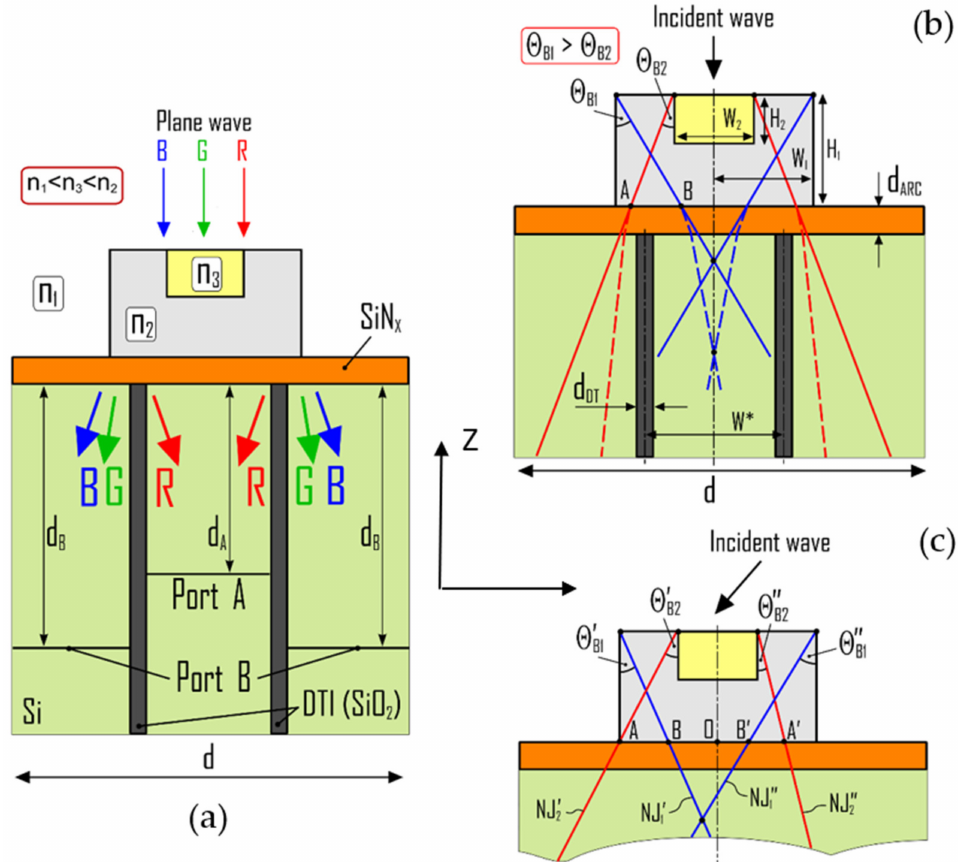
Figure 1. ( a ) Topology of a NJ-based dielectric color splitter for normal incidence; ( b ) Cross-section view of a color splitter with parameters of the system; ( c ) NJ generation by double-material elements for an inclined incidence of a plane